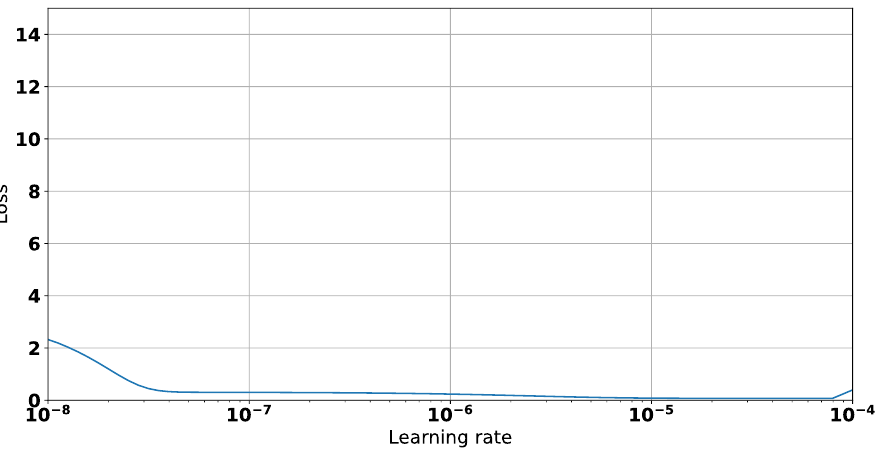
Figure 5. Learning rate schedule output—CNN.